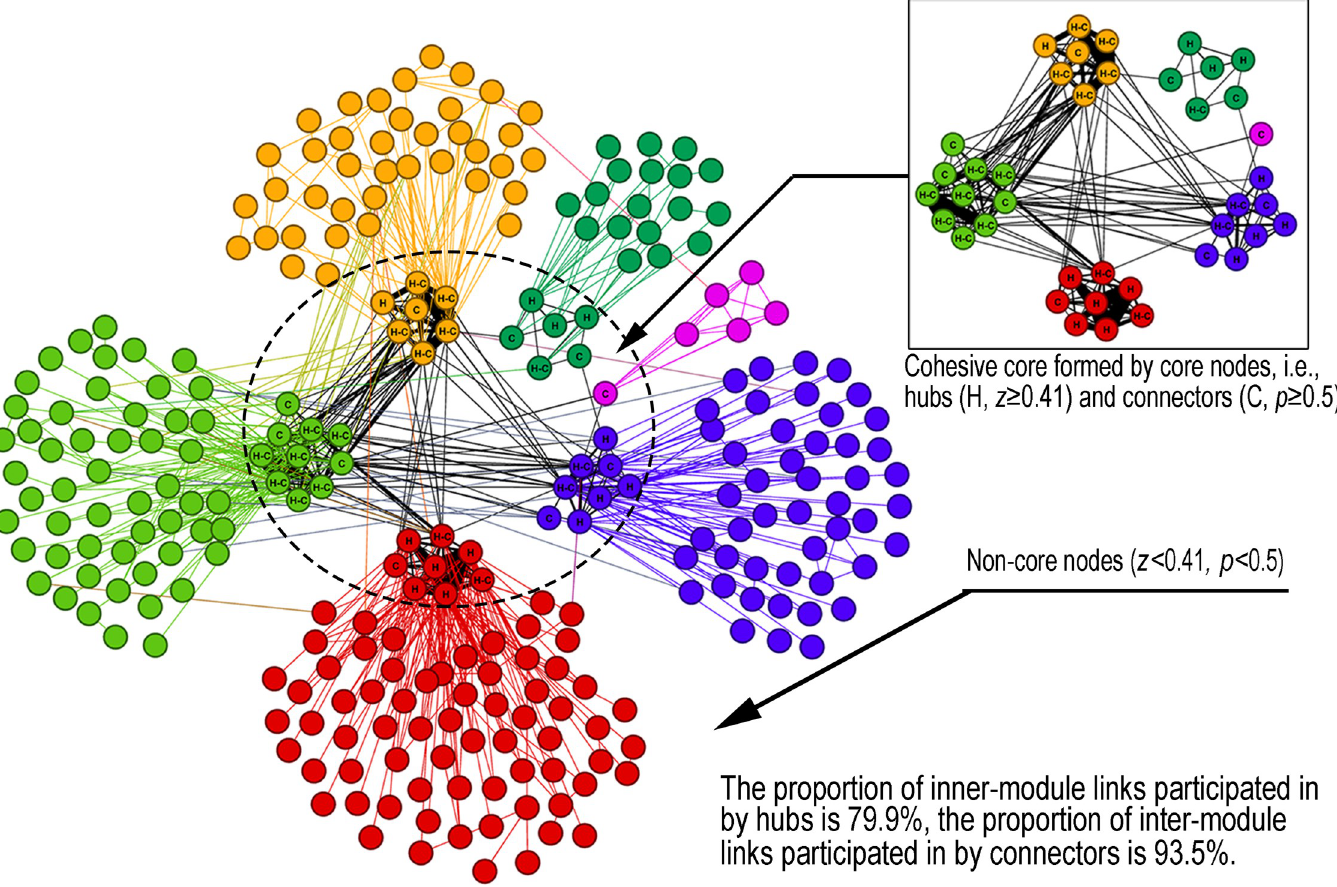
Fig 12. Maintenance role of core nodes in network structure